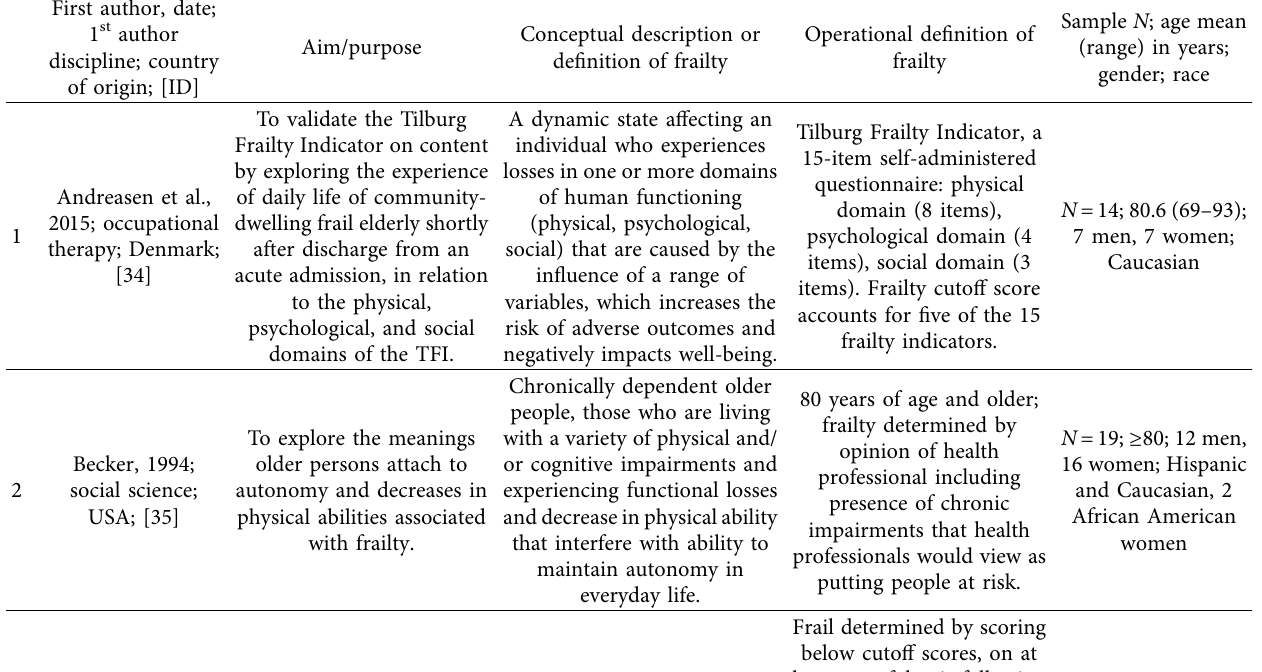
Table 1: Description of the qualitative research articles in the study sample ( N �